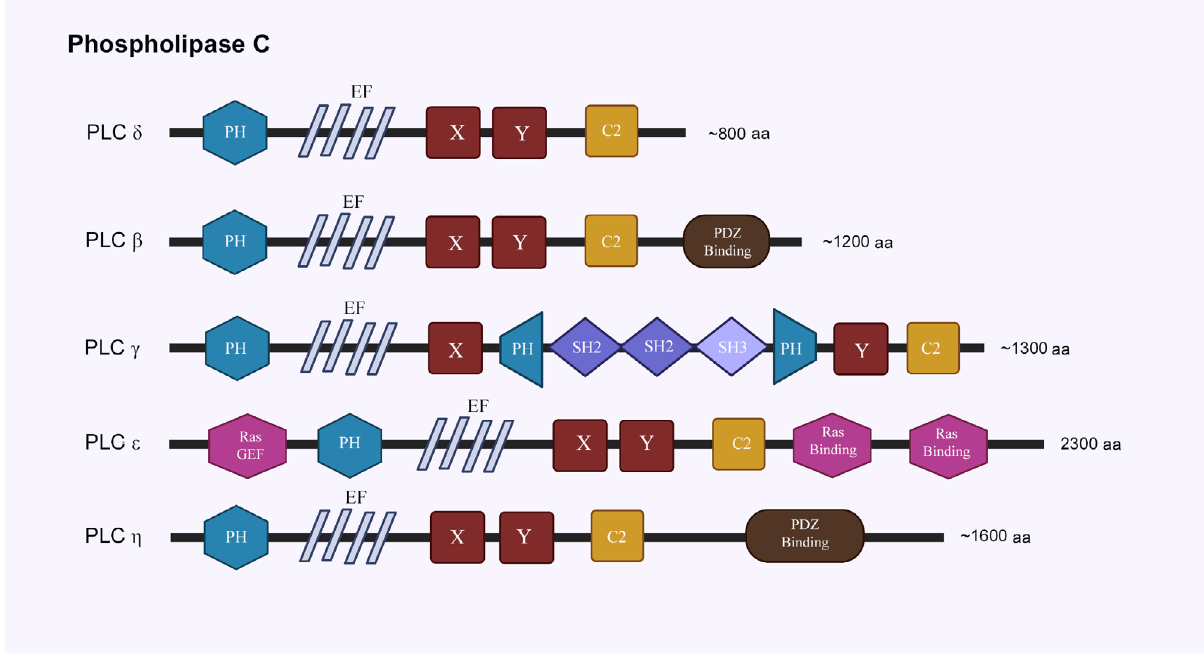
Figure 4. Structural features of phospholipase C family. EF: helix-loop-helix motif; X,Y: TIM barrel domain; SH2: Src homology 2 domain; SH3: Src homology 3 domain. The schematics for structural domains are not to